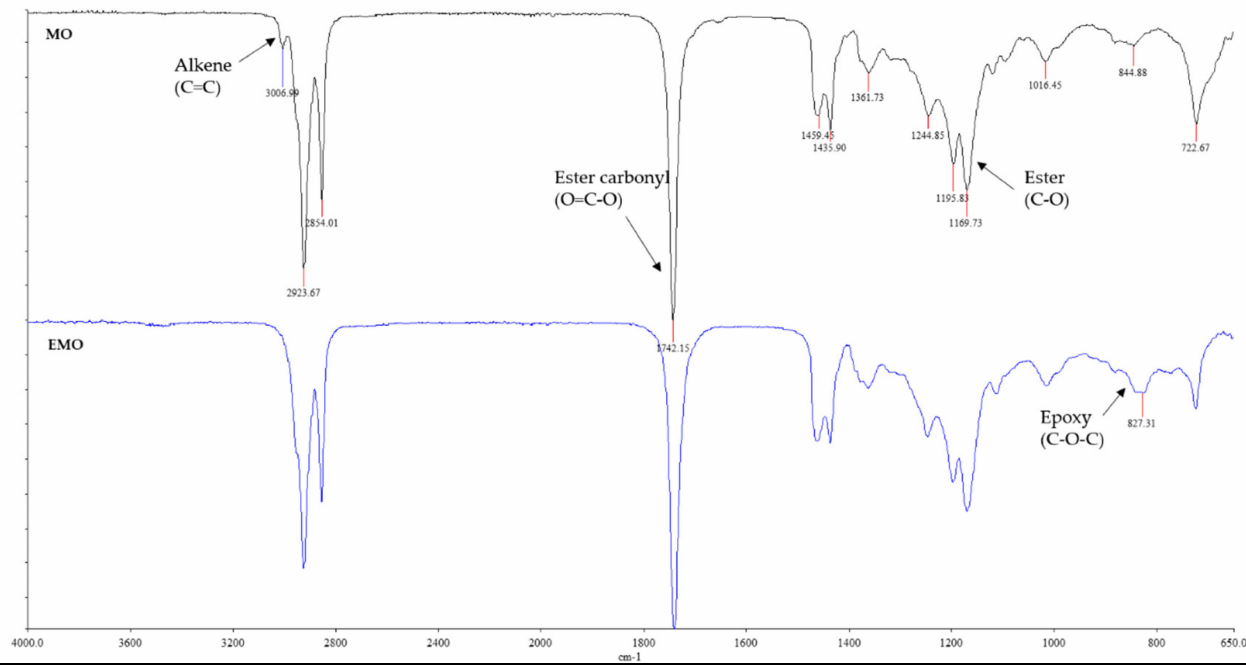
Figure 2. FTIR spectra of Methyl oleate (MO) and Epoxidised methyl oleate